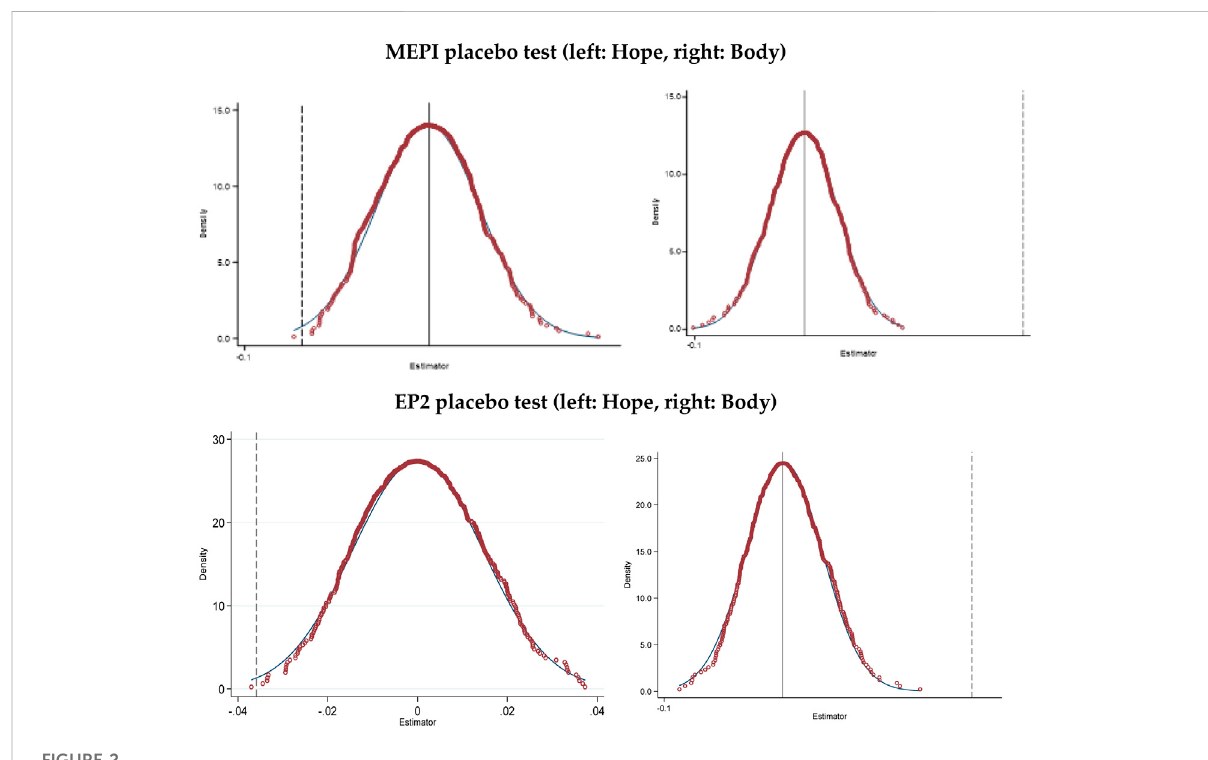
FIGURE 2 MEPI, EP2 placebo test. MEPI placebo test (left: Hope, right: Body).